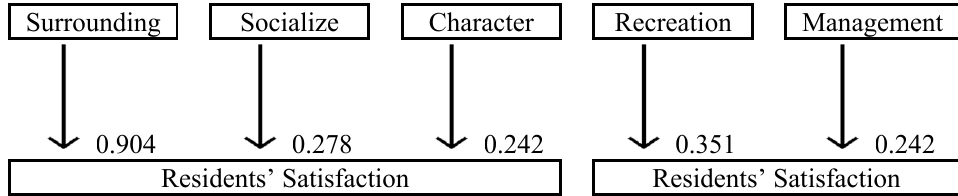
Figure 9. Final influencing factors of Nanhuan ( left ) and Daoqian ( right ).